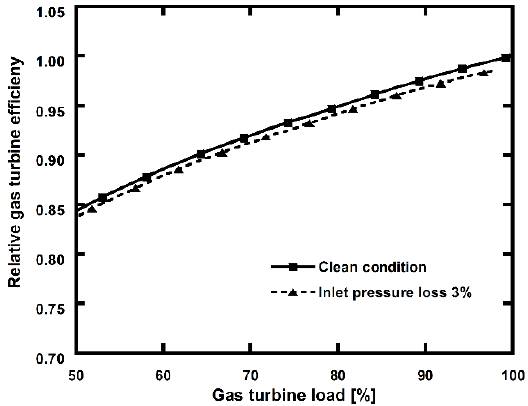
Figure 13. Variations in the partial load efficiency with the schedule-based control.